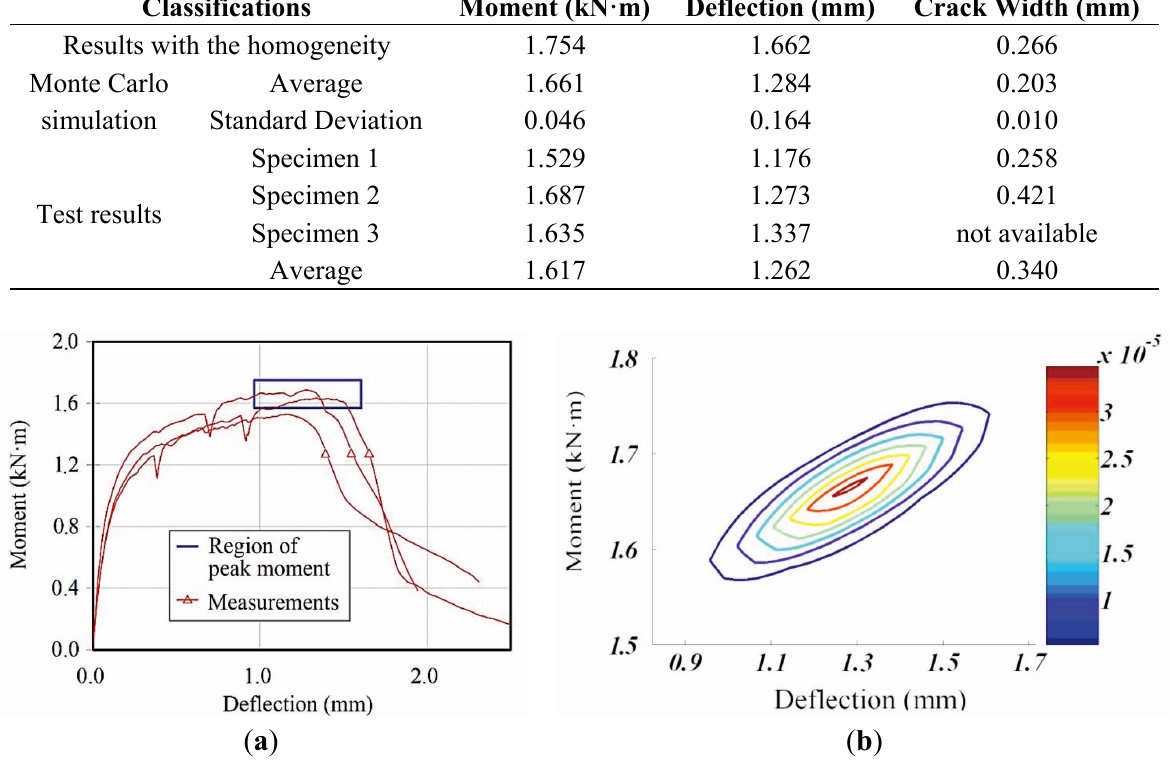
Figure 13. Region of peak moment and deflection obtained with 99% certainty: ( a ) peak moment and deflection region; ( b ) probabilistic distribution on peak moment and